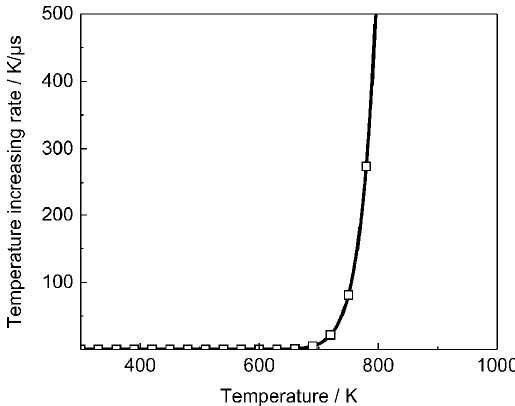
Figure 10. Temperature increasing rate calculated by Arrhenius reaction model.